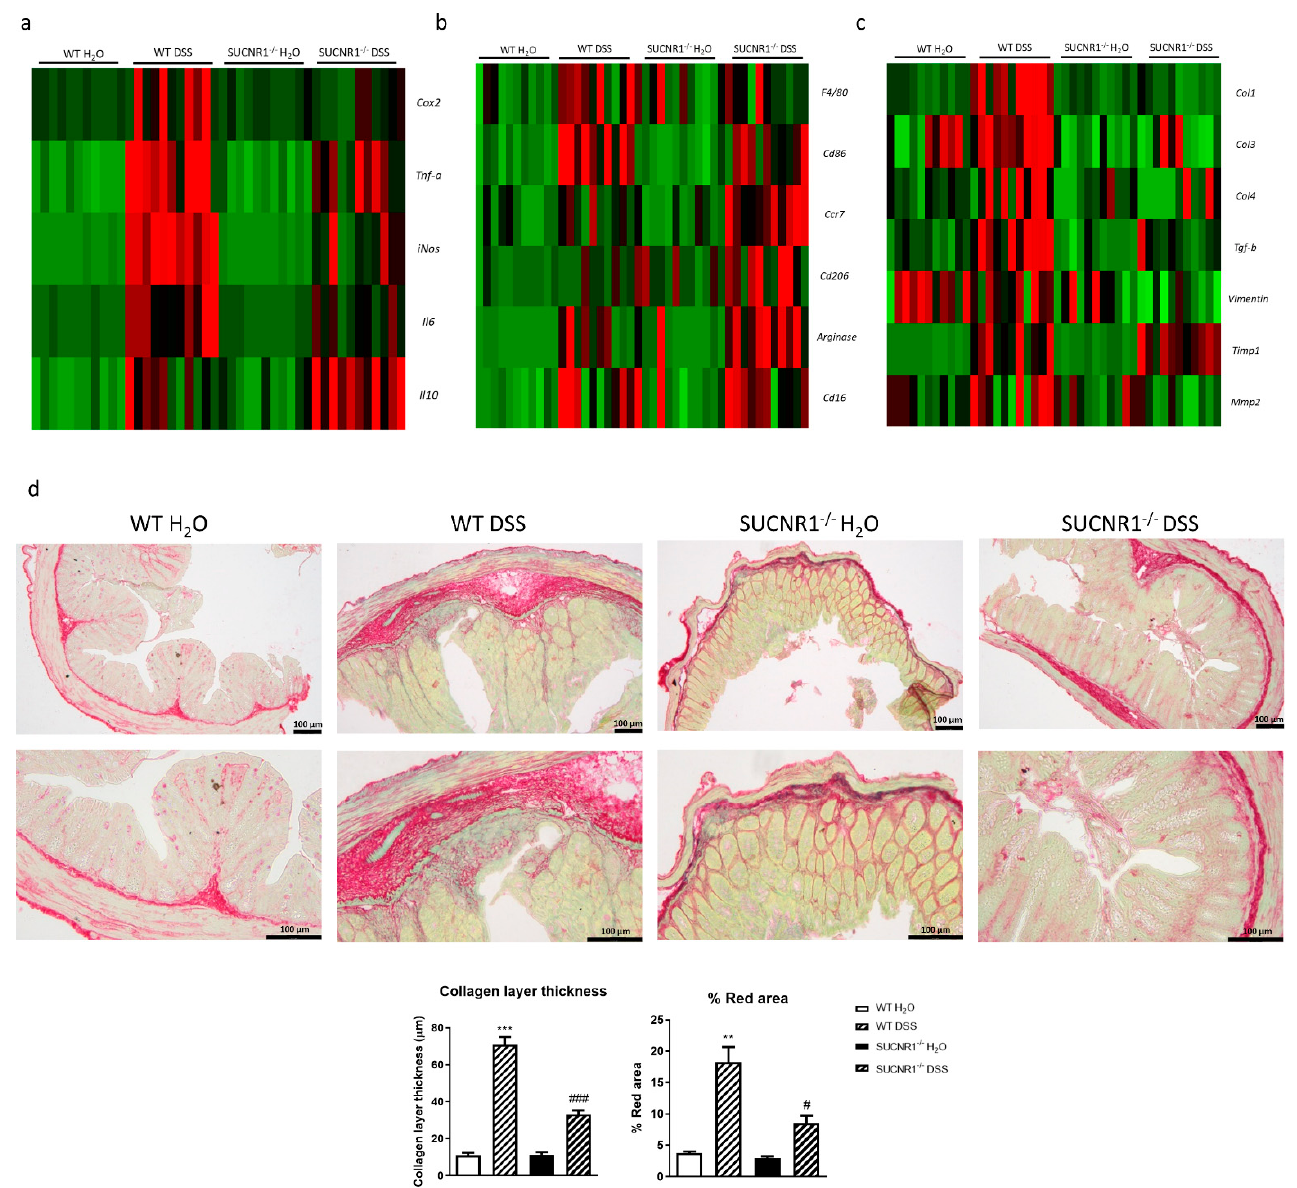
Figure 5. SUCNR1 deficiency reduces intestinal inflammation and fibrosis in DSS-chronic colitis. Intestinal colitis was induced in vivo in WT and SUCNR1 − / − mice with four cycles of increasing percentage of DSS in drinking water over 7 days, intercalated with 10 days of water. At the end of the last cycle, on day 60, mice were euthanized and colon tissue samples were collected. ( a ) Heat map showing the mRNA expression of proinflammatory and anti-inflammatory cytokines including Cox2, Tnf-a, iNos, IL6 and Il10 . ( b ) Heat map showing the mRNA expression of macrophage infiltration and phenotype markers such as F4/80, Cd86, Ccr7, Cd206, Arginase and Cd16 . ( c ) Heat map showing the mRNA expression of profibrotic markers including Col1, Col3, Col4, Tgf-b, Vimentin, Timp1 and Mmp2 . ( d ) Sirius-Red staining performed on intestinal resections of WT and SUCNR1 − / − mice and representative images of each group ( n = 8). In addition, quantification of the collagen layer thickness as well as % of red area is also represented. Bars in graphs represent mean ± SEM. ** p < 0.01 and *** p < 0.001 vs. WT H 2 O mice. # p < 0.05 and ### p < 0.001 vs. WT DSS-treated